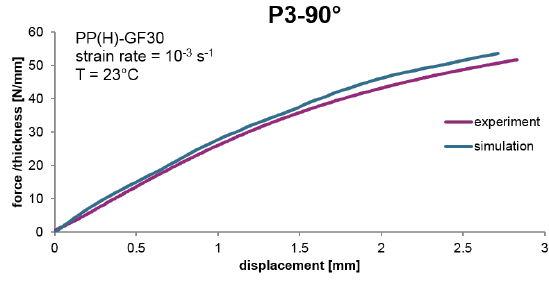
Figure 12. Comparison of stress-strain curves of experiment and simulation performed in Abaqus 6.14 with fitted failure parameters.